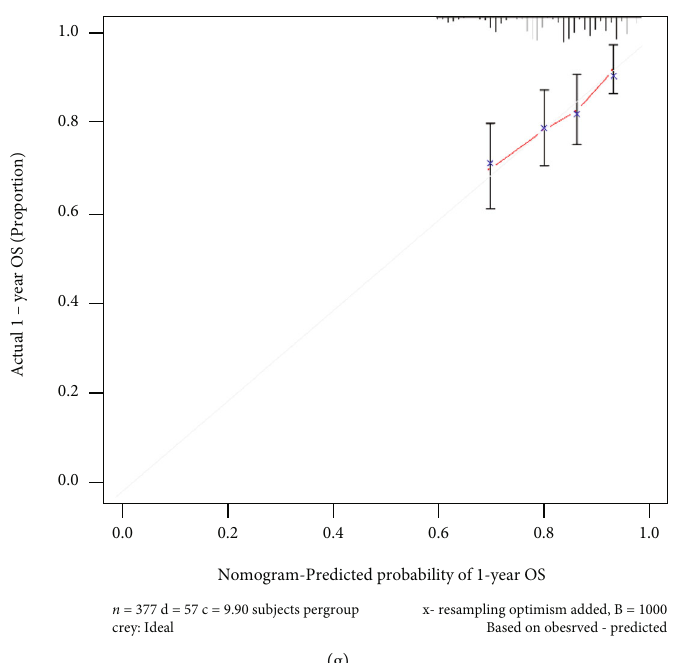
Figure 5: Correlation between RMA-AS_Score prognostic signature and clinical features and construction of the clinicopathological map. (a – c) Correlation of risk score with gender, stage, and tumor grade. (d) The AUC of RMA-AS_Score prognostic signature and clinical parameters. (e) The AUC of 1-, 2-, and 3-year survival. (f) Nomogram was constructed by using RMA-AS_Score signature and clinical parameters. (g) The nomogram calibration plot in